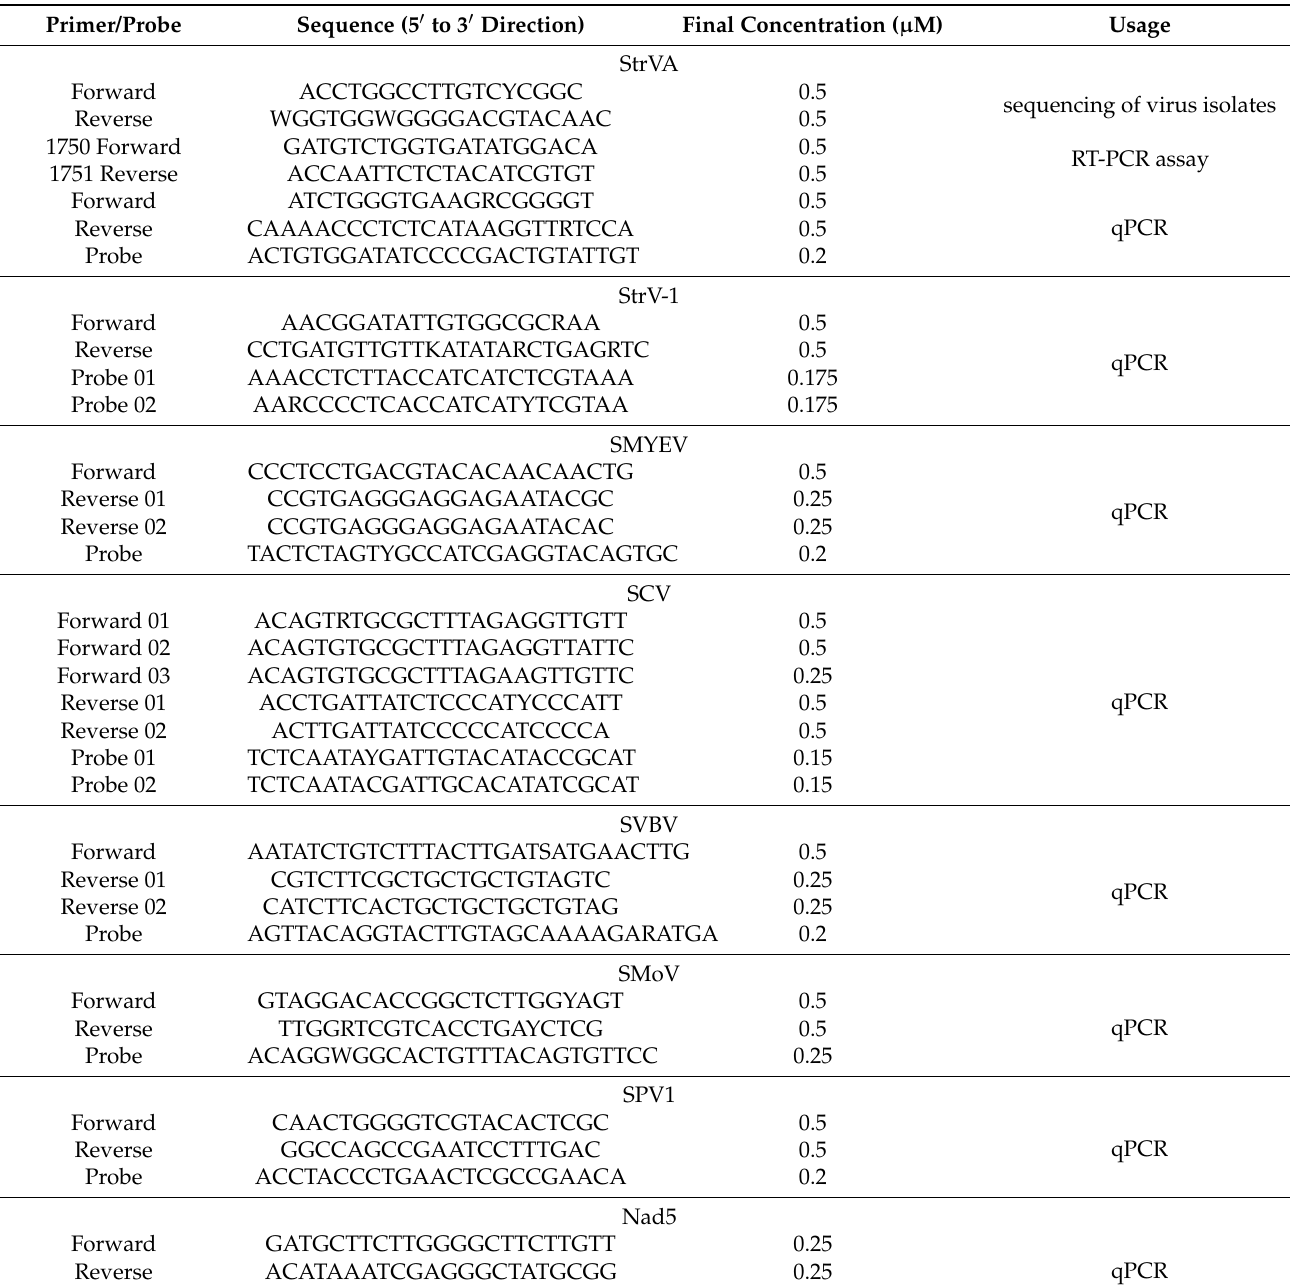
Table 3. List of primers used in the